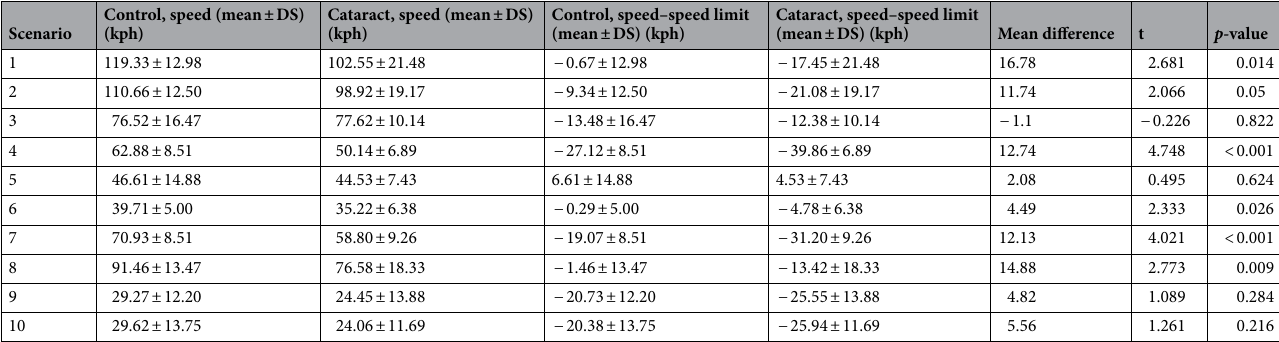
Table 4. Comparison of speed self-regulation in drivers with and without cataract for scenarios of varying driving difficulty. Mean speed and mean speed adaptation with respect to the speed limit are included.